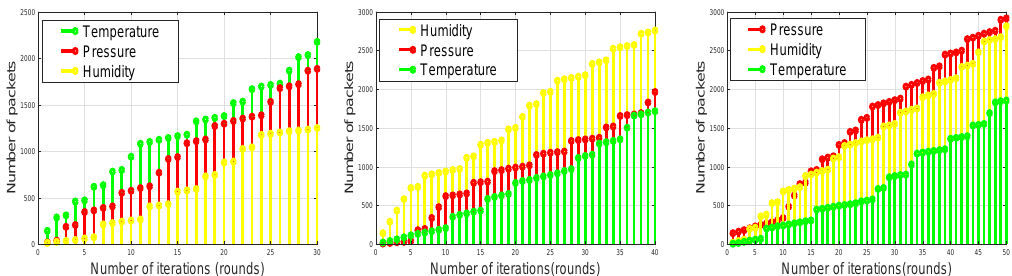
Figure 5. Application-sensitive environmental reporting of the SACFIR routing protocol.